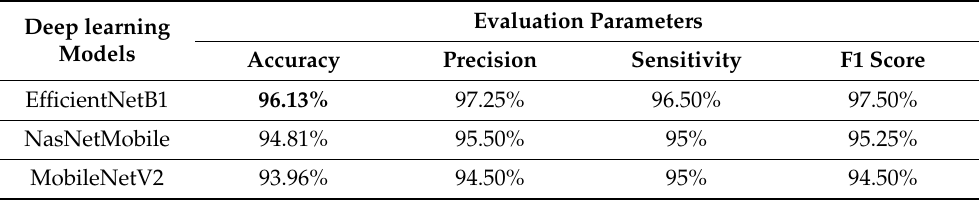
Table 4. Classification results using Strategy